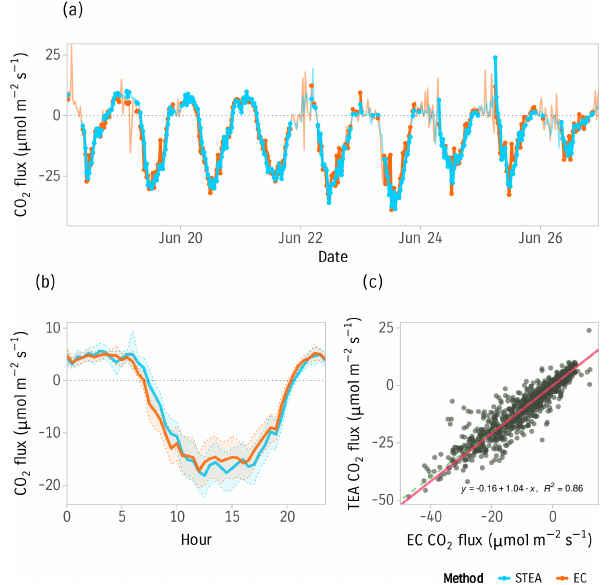
Figure 8. STEA and EC flux intercomparison. (a) Time series of EC and STEA CO 2 fluxes for a subset period of 9d. Points and thick lines indicate the averaging intervals used for comparison after filtering for quality. (b) Mean diurnal cycle of CO 2 fluxes of STEA and EC. Bands are 95% confidence intervals of the mean calculated using nonparametric bootstrapping. (c) Scatter plot of STEA CO 2 fluxes against reference EC fluxes. The red line is the linear fit using orthogonal distance regression (ODR). The dashed green line is a 1-to-1 line for reference. Data used for panels (b) and (c) are from